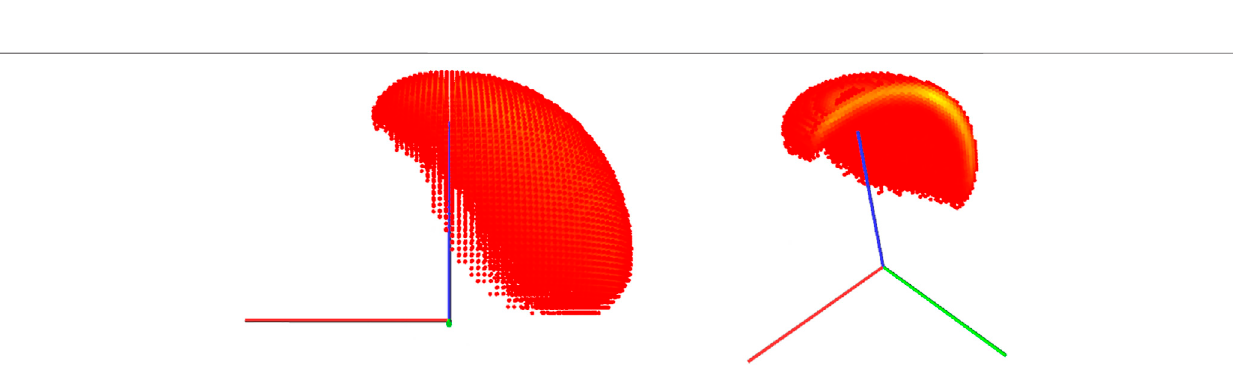
Frontiers in Robotics and AI |